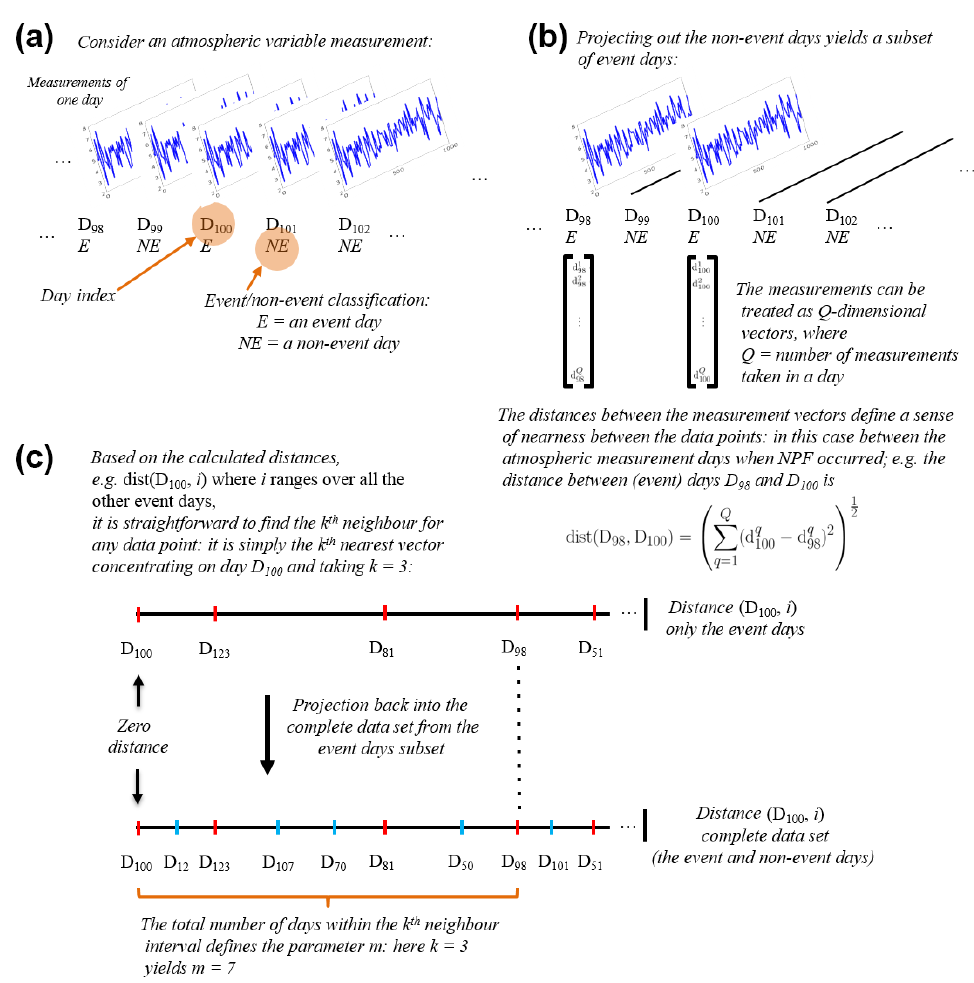
Figure 4. An illustration of the computing process for the mutual information estimator based on the nearest-neighbour